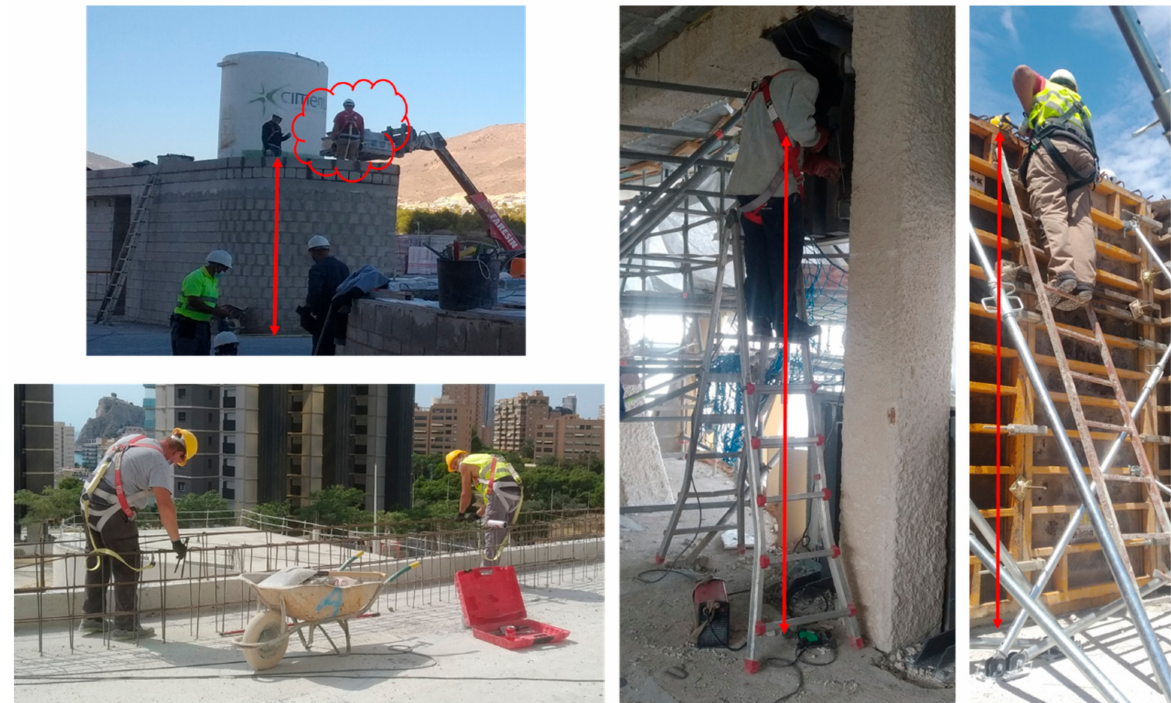
Figure 2. FAS with EAL near the ground level.